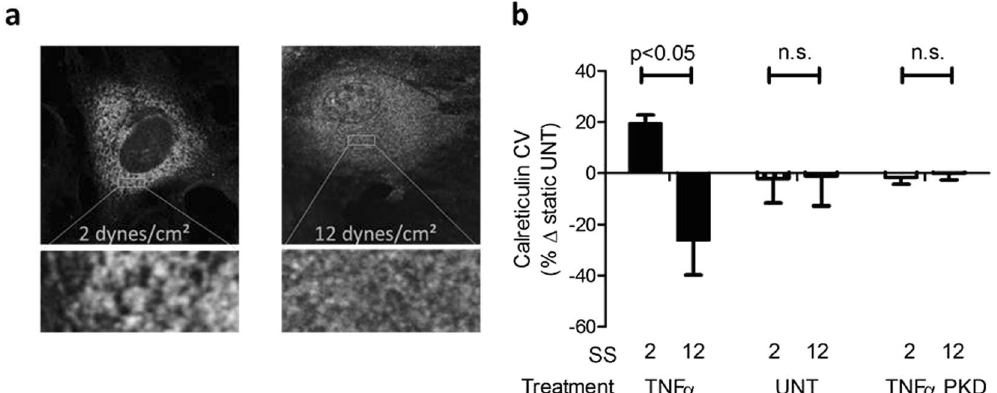
Figure 2. ER expansion is altered by SS in a PECAM-1 dependent manner. HAEC expressing and lacking the mechanosensitive protein PECAM-1 were exposed to TNF α (0.3 ng/ml) and SS for 4 hrs and immunolabeled for the ER resident protein calreticulin. ( a ) Representative confocal images from low (2 dynes/cm 2 ) and high (12 dynes/cm 2 ) SS regions in TNF α -stimulated cells. ( b ) Coefficient of variation (CV) of calreticulin pixel intensity, a measure of ER expansion associated with ER stress. Values are mean ± SE, n = 3–5.